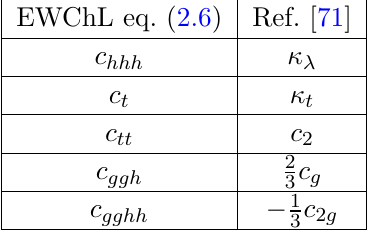
Table 2. Translation between the conventions for the de(cid:12)nition of the anomalous couplings.